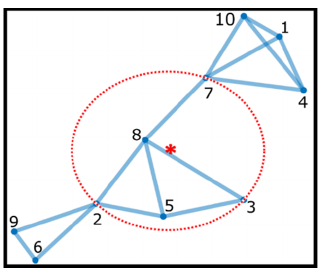
Figure 2. Example of circumcenter rendezvous showing the smallest involving circle around robot 8 direct neighbors and its center as reference for that robot in that time